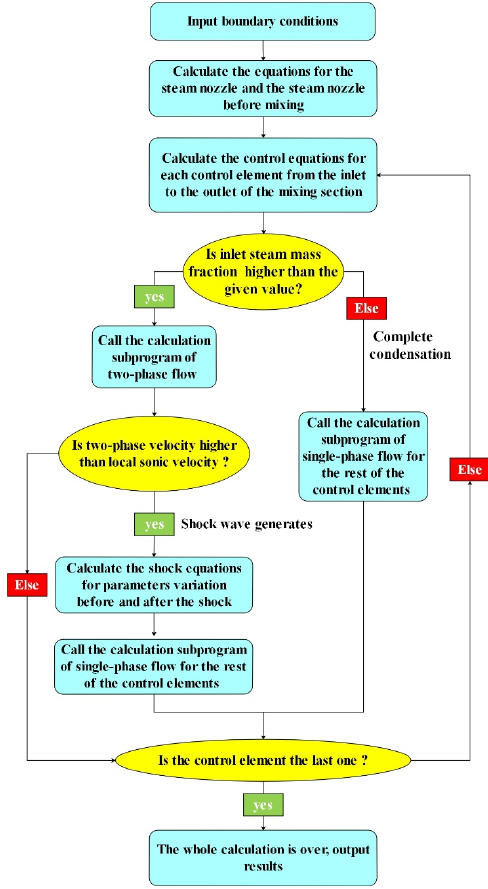
Figure 3. Solution process of the